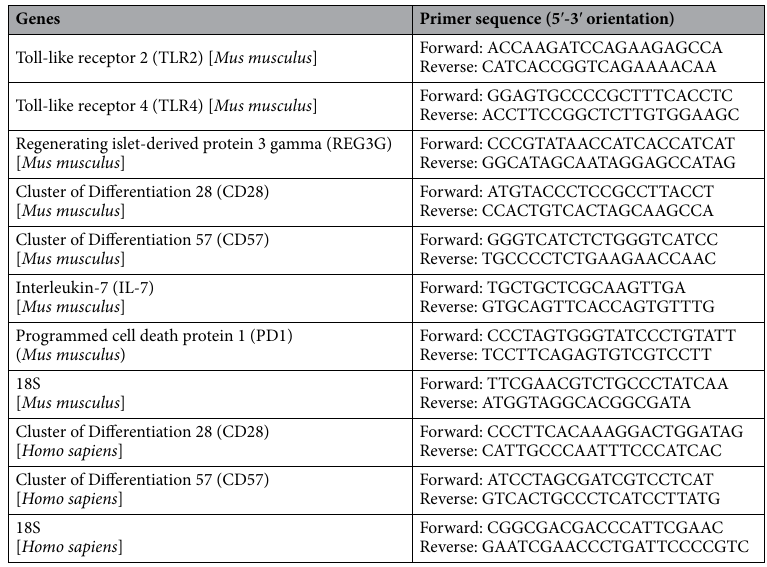
Table 1. qRT-PCR Primer sequences. Detailed forward and reverse primer sequences used for qRTPCR are